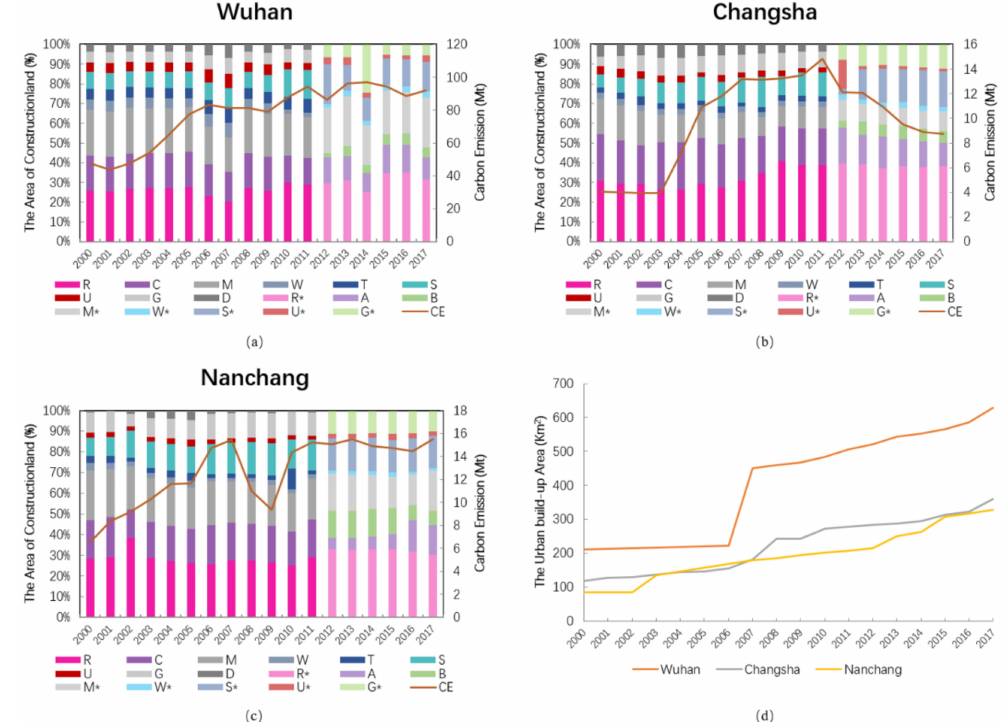
Figure 2. Area of construction land (The legend of construction land is as follows: 2000–2011: R–residential land, C–land for public facilities, M–industrial land, W–land for storage, T–land for transportation system, S–land for roads and plazas, U–land for municipal utilities, G–green land, D–land for special purposes. 2012–2017: R *–residential, A–administration and public services, B–commercial and business facilities, M *–industrial, manufacturing, W *–logistics and warehouse, S *–road, street, and transportation, U *–municipal utilities, G *–green space and square) and built-up in Wuhan, Changsha, and Nanchang. ( a ) Wuhan, ( b ) Changsha, ( c ) Nanchang, ( d ) Built-up area in Wuhan, Changsha and